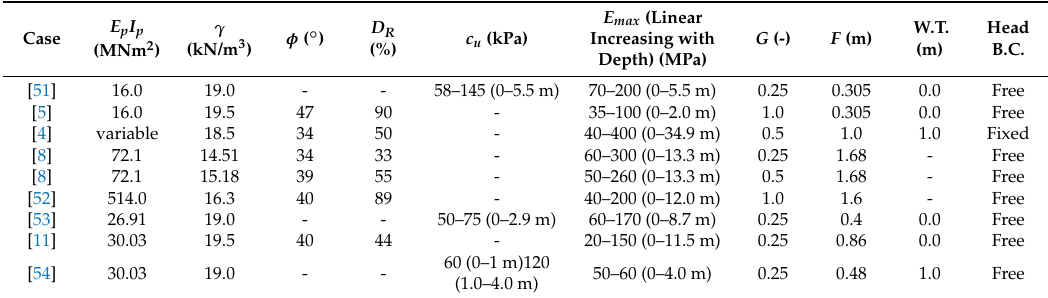
Table notes: E p I p = pile flexural rigidity; γ = soil unit weight; φ = peak friction angle; D R = relative density; c u = undrained shear strength; E max = soil elastic modulus at small strain level; g = parameter of the modulus